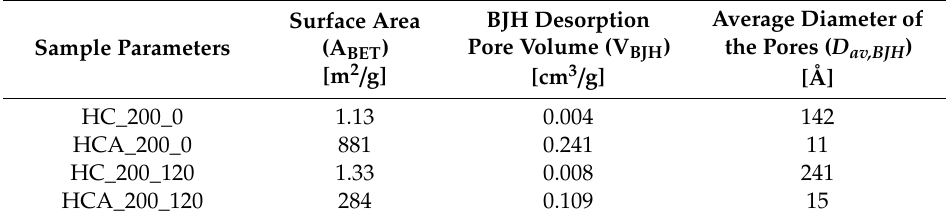
Table 2. BET and BJH results of all materials tested.